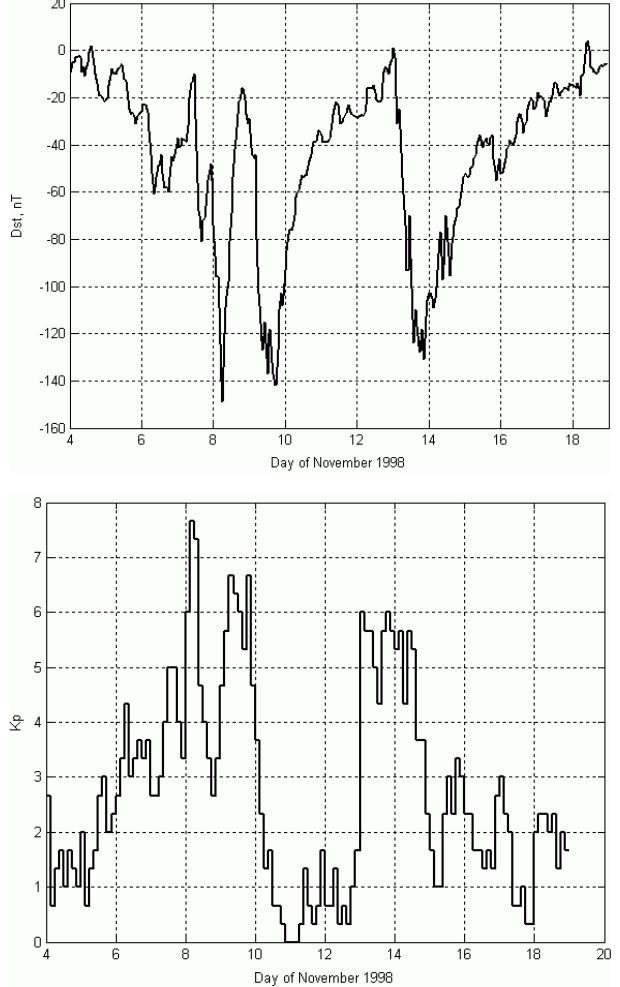
Fig. 2. D st and K p indexes during the experiment.